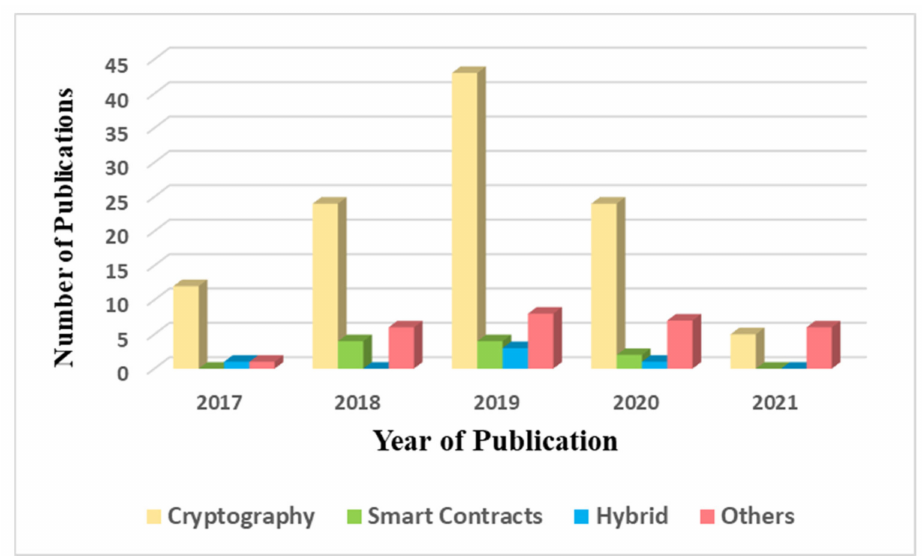
Figure 5. Latest trends in blockchain based privacy preserving solutions.